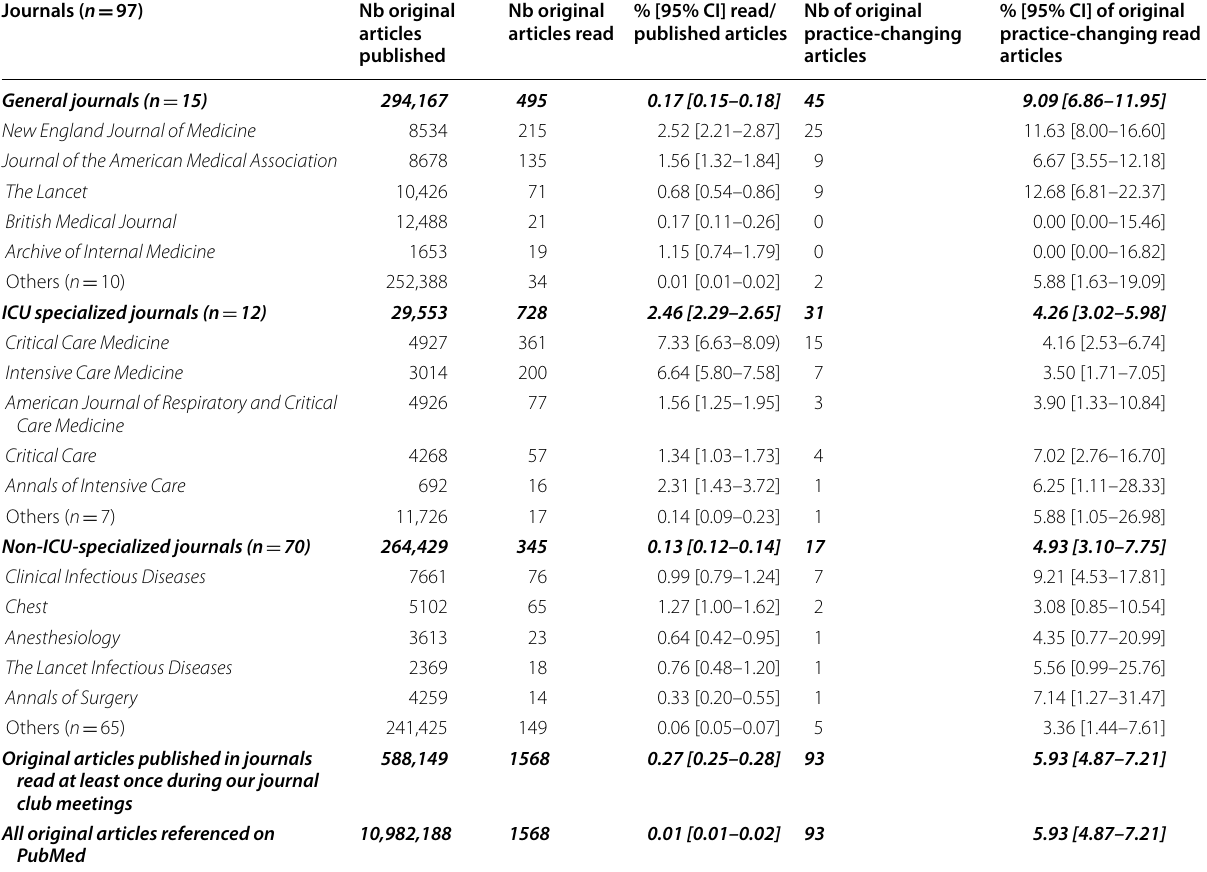
Table 1 Number of original articles published from August 2007 to August 2019 in the 5 most read journals during our journal club meetings in the 3 journal categories, percentages of articles exposed during our journal club